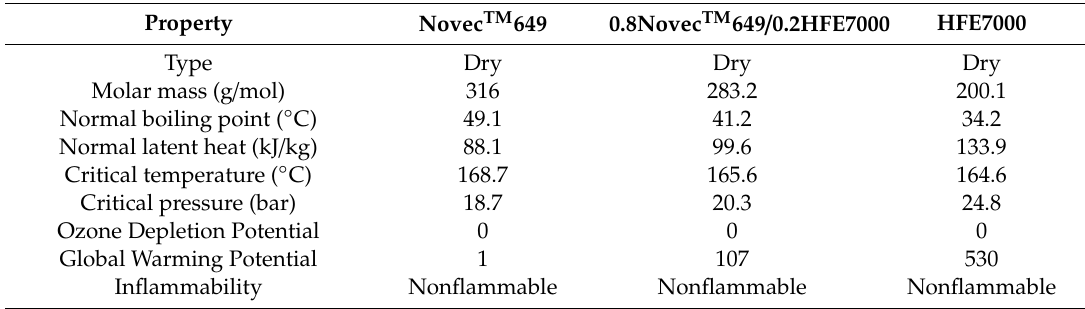
Table 1. The main properties of the considered